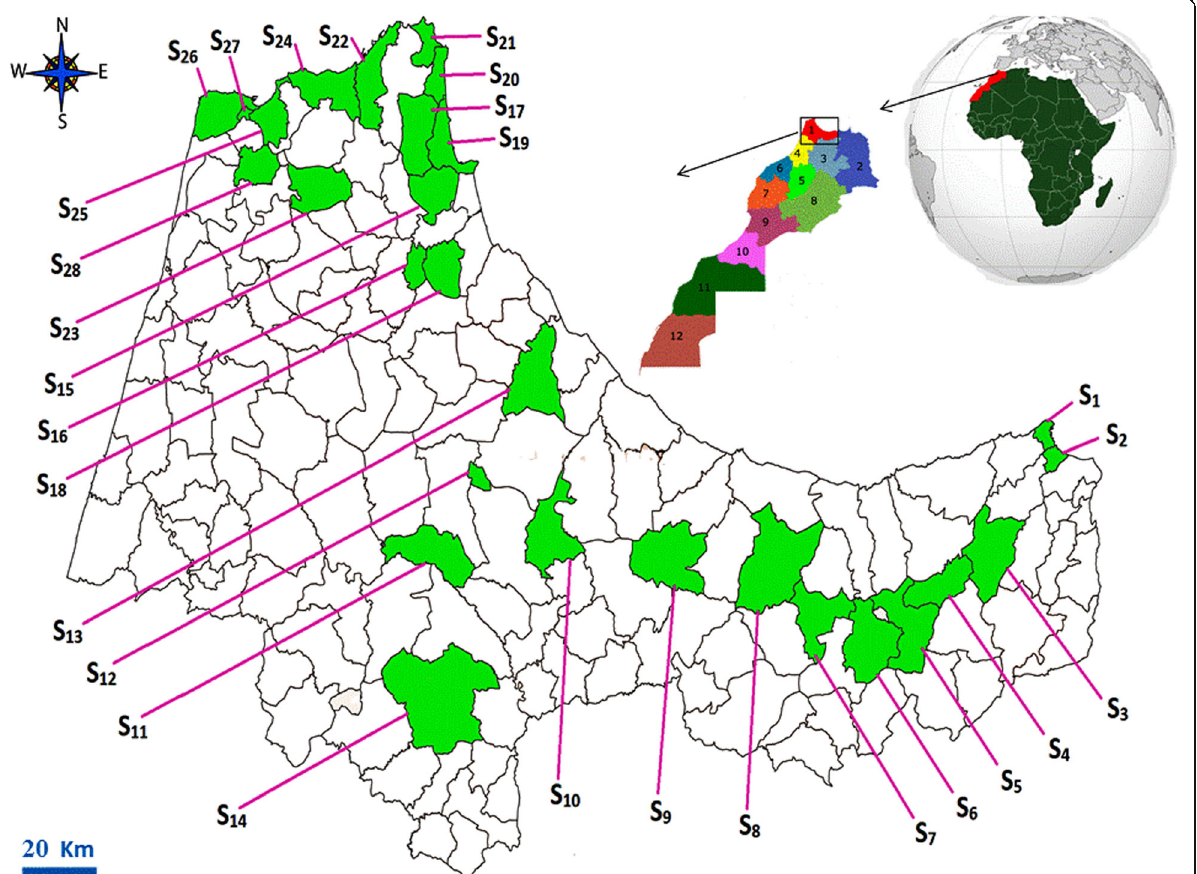
Fig. 1 Geographical location of the Rif,